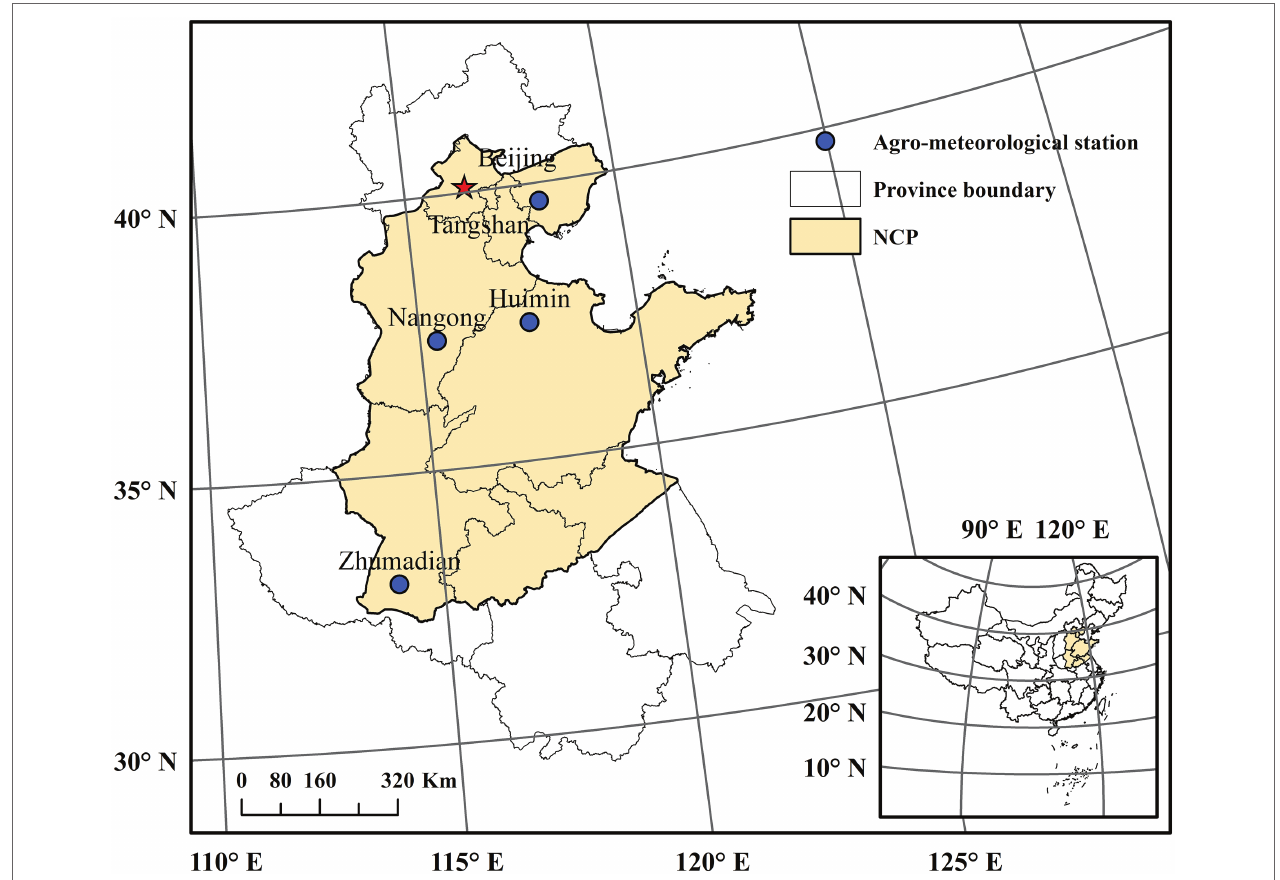
FIGURE 1 | Locations of the four investigated agro-meteorological stations in the North China Plain (NCP).